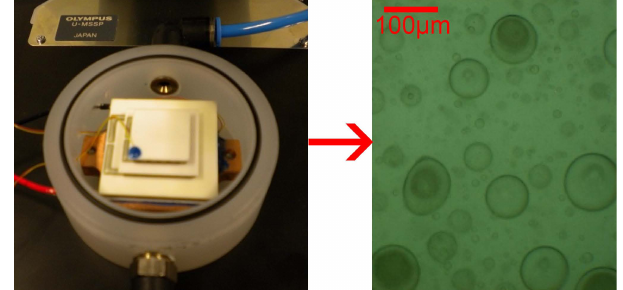
Fig. 3. The cryo cell used for oil immersion measurements, and a partly frozen pure water emulsion photographed at 237K.